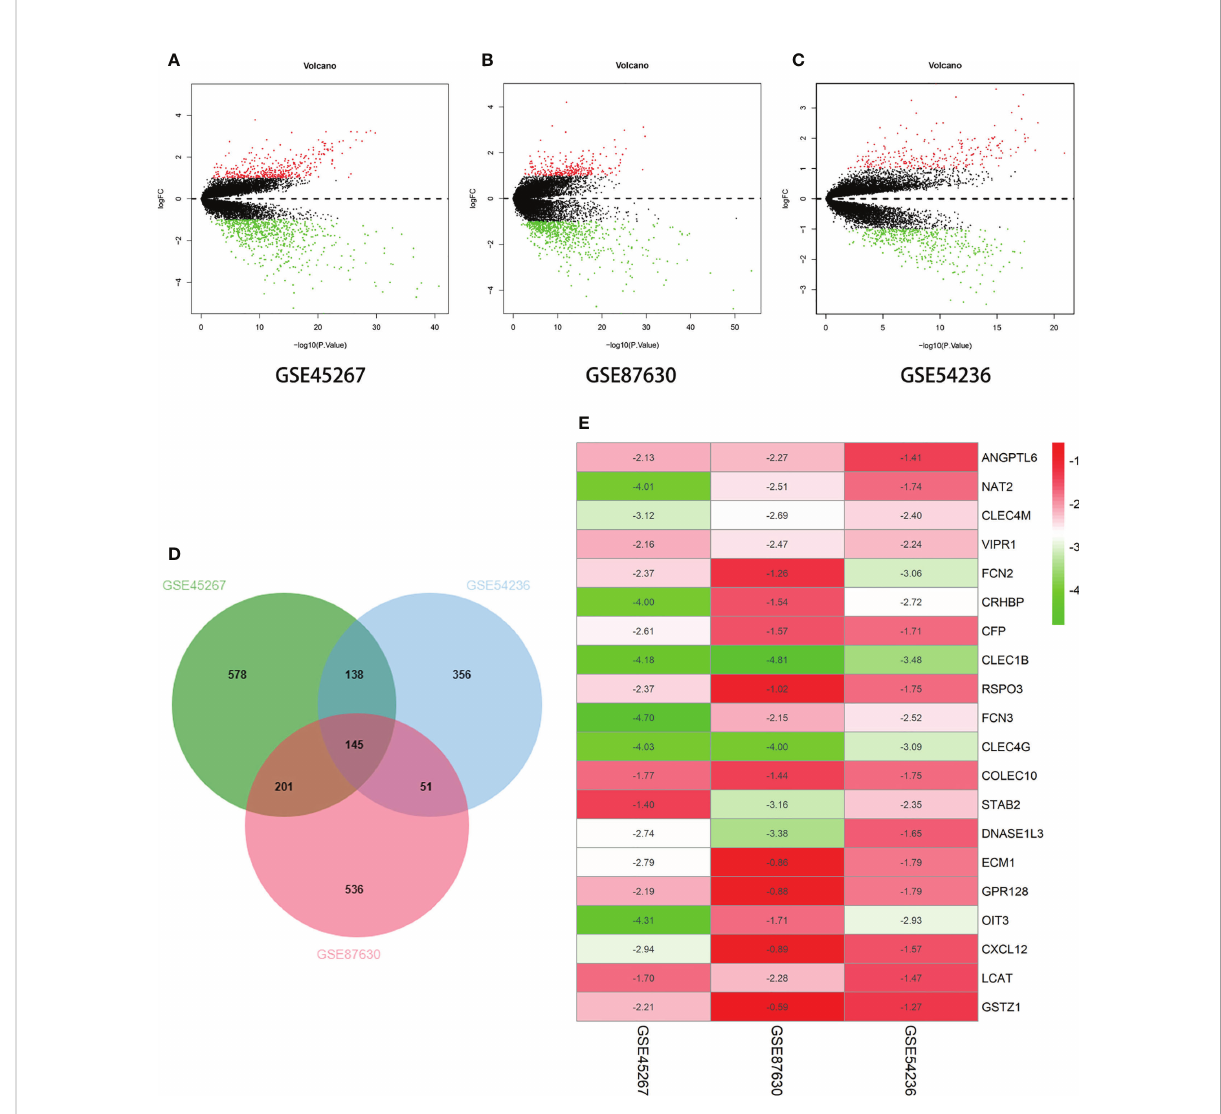
FIGURE 1 Differential expression of multiple genes in the three datasets. (A) GSE45267 dataset. (B) GSE87630 dataset. (C) GSE54236 dataset. (D) Identi fi cation of the signi fi cantly differentially expressed genes (DEGs) in hepatocellular carcinoma (HCC) in the GSE45267, GSE87630, and GSE54236 datasets established the intersection of the DEGs. (E) The 20 genes with signi fi cant downregulation obtained using the RobustRankAggreg (RRA) algorithm. Taking |logFc| > 1 as the boundary value, p <